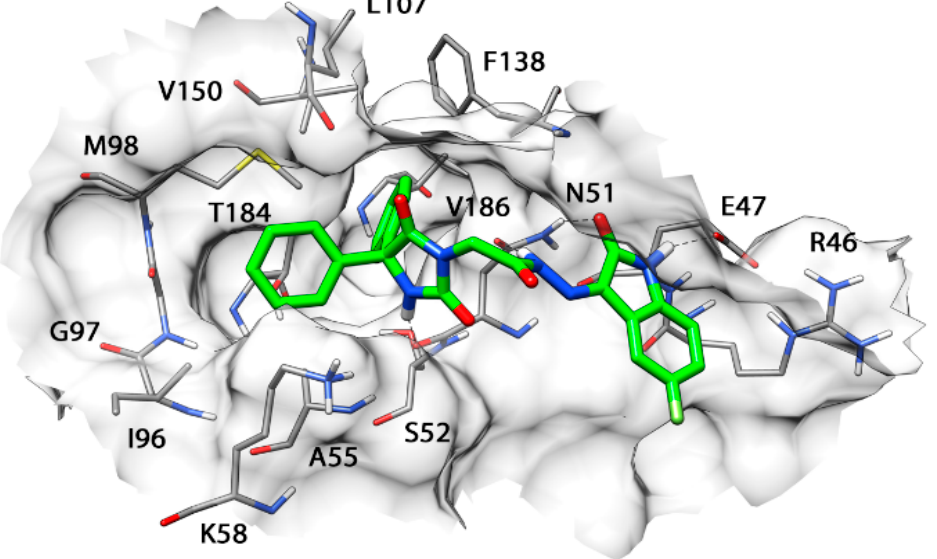
Figure 8. Minimized average structure of HAA 2021 bound to Hsp90 α .